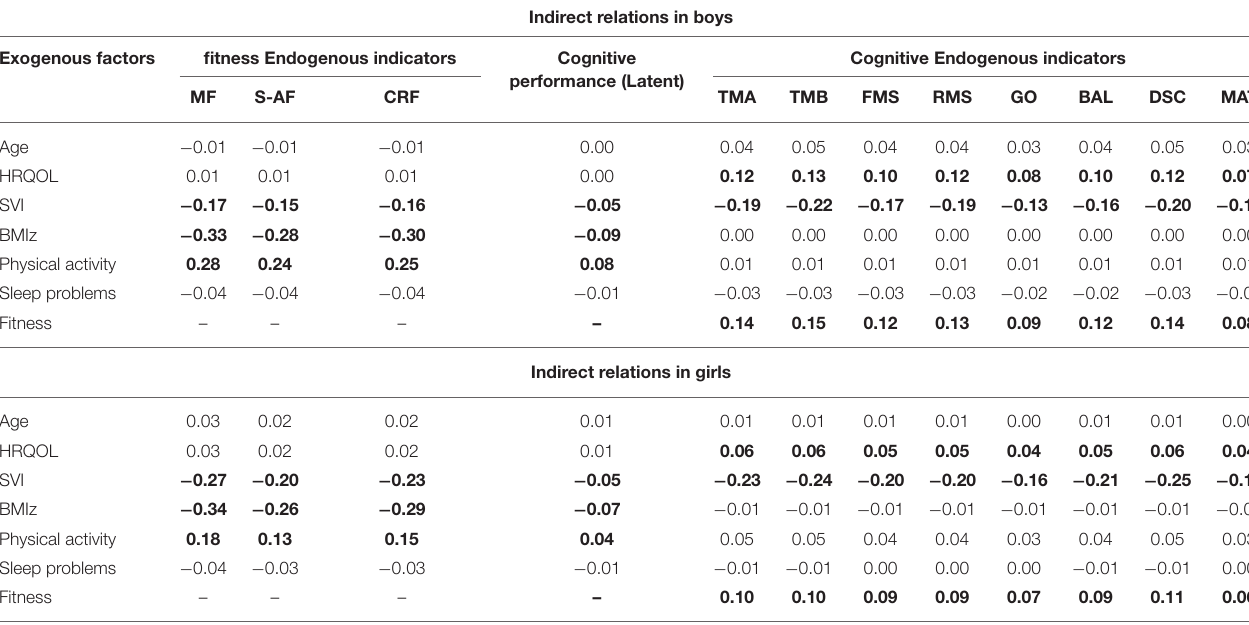
TABLE 2 | Indirect relationships in the structural equation model for boys and